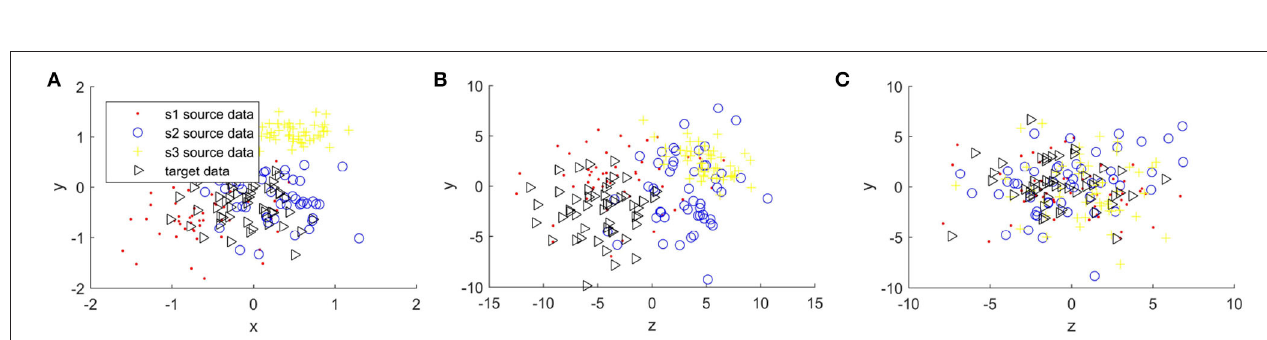
FIGURE 4 | Sample distribution comparison of features in their original space and normalized projected spaces in the MAHNOB-HCI database, (A) is MAHNOB original features, (B) is Unnormalized features + brain region aware domain adaptation (BRADA), and (C) is Normalized features + BRADA.